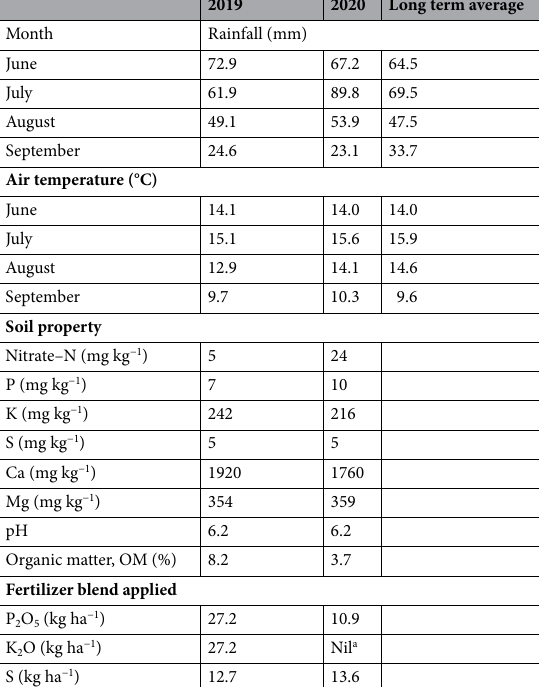
Table 1. Rainfall, temperature, and soil properties (0–15 cm depth increment) at the experimental site, as well as the basal fertilizer applied in 2019 and 2020. a Soil tests indicated adequate availability of soil K, so no additional K 2 O was